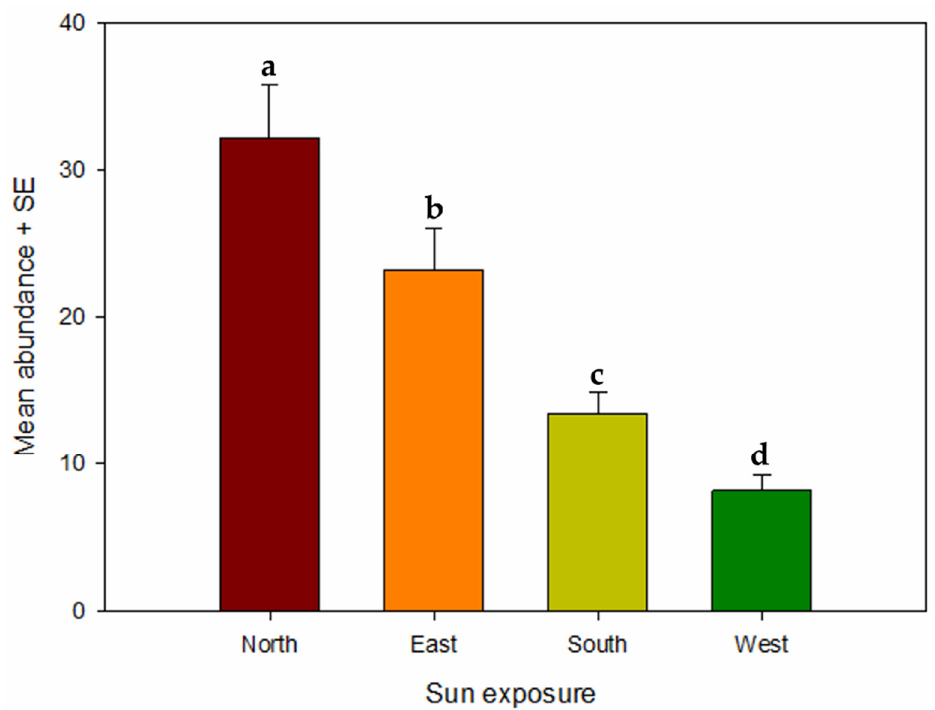
Figure 3. Thrips abundance at different sun exposure sectors of plant canopies. The different superscript letters show significant differences among the mean values ( p < 0.05).